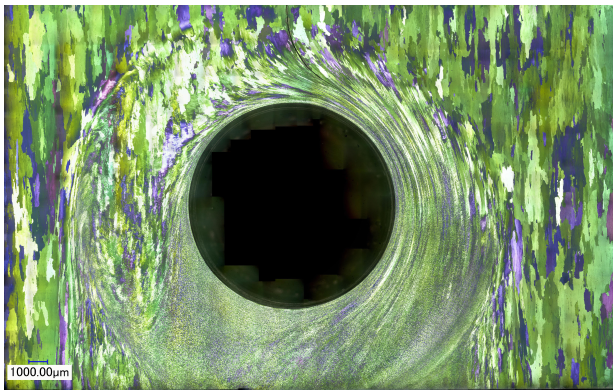
Figure 2. Shear bands produced during FSW of the Aluminum alloy AA2050 with an advancing side on the